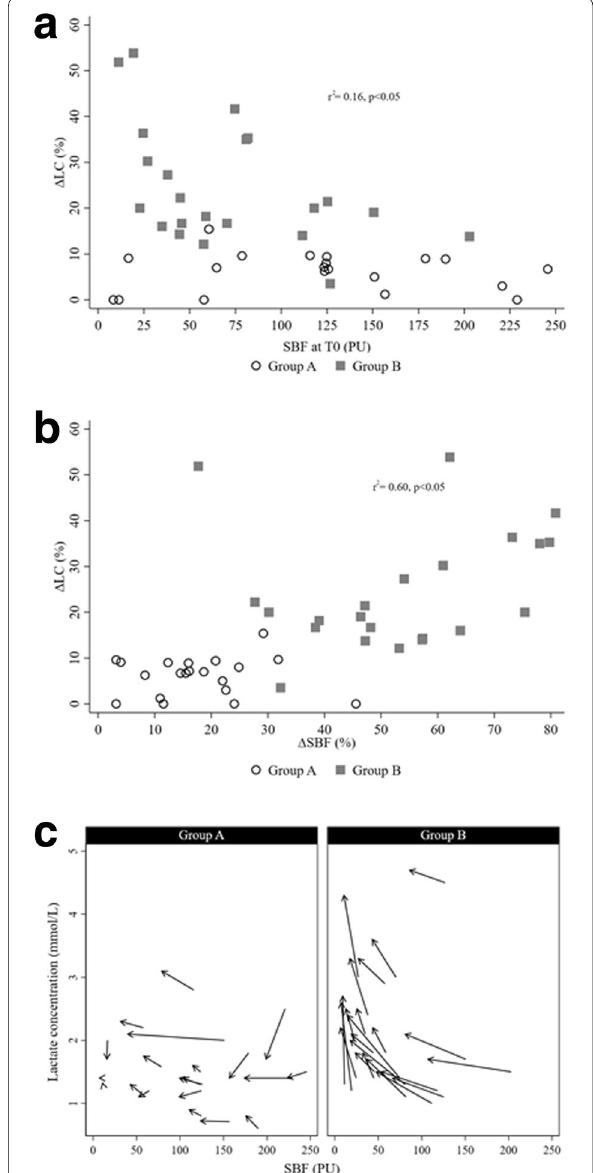
Fig. 2 Correlations between change in lactate concentration (∆LC%) and a skin blood flow (SBF) at baseline (T0) and b change in SBF over first hour of fluid removal with CVVHDF (∆SBF%); c individual change in SBF and lactate concentration from baseline to 6 h after start of fluid removal with CVVHDF in groups A and B